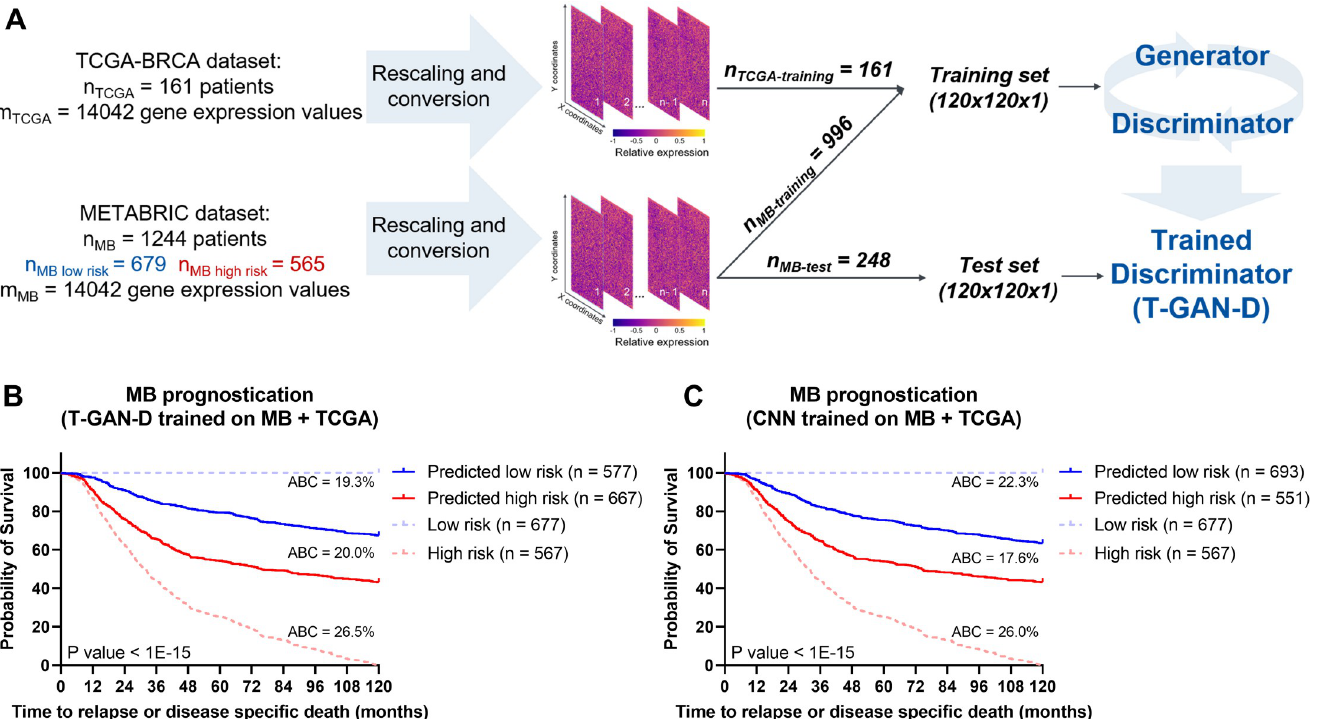
Fig 3. Introducing the independent TCGA cohort improves MB patient classification. ( A ) Schematic representing the training strategy: rescaled data from the entire TCGA cohort were merged with 4/5 of the MB cohort to train the T-GAN-D, which was subsequently used to predict the risk class of the remaining 1/5 of MB patients. The process was iterated 5 times. ( B ) Kaplan-Meier curves based on the pooled predictions of the T-GAN-D trained on both cohorts. ( C ) Kaplan-Meier curves separating low vs. high risk patients predicted with the CNN that was trained after merging the MB and the TCGA cohorts. The area between the curves (ABC) between Low risk (blue dashed line) and Predicted low risk (solid blue line), Predicted low risk and Predicted high risk (solid red line), Predicted high risk and high risk groups (dashed red line) are shown top to bottom in B and C .